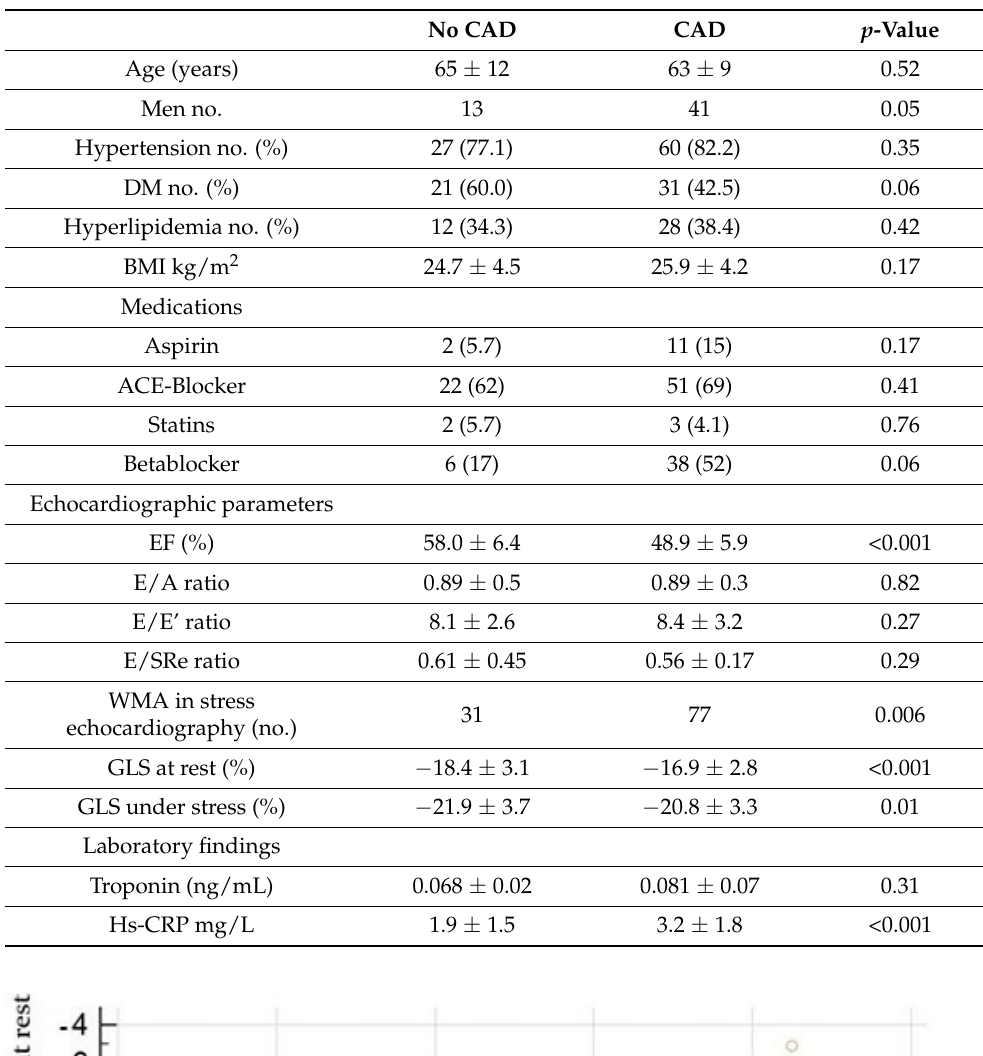
Table 1. Baseline characteristics based on presence or absence of coronary artery disease (CAD). No: number. %: percentage in each group (no CAD or CAD group). DM: diabetes mellitus. EF: ejection fraction. GLS: global longitudinal strain. Hs-CRP: high-sensitivity C-reactive protein. WMA: wall motion abnormality.